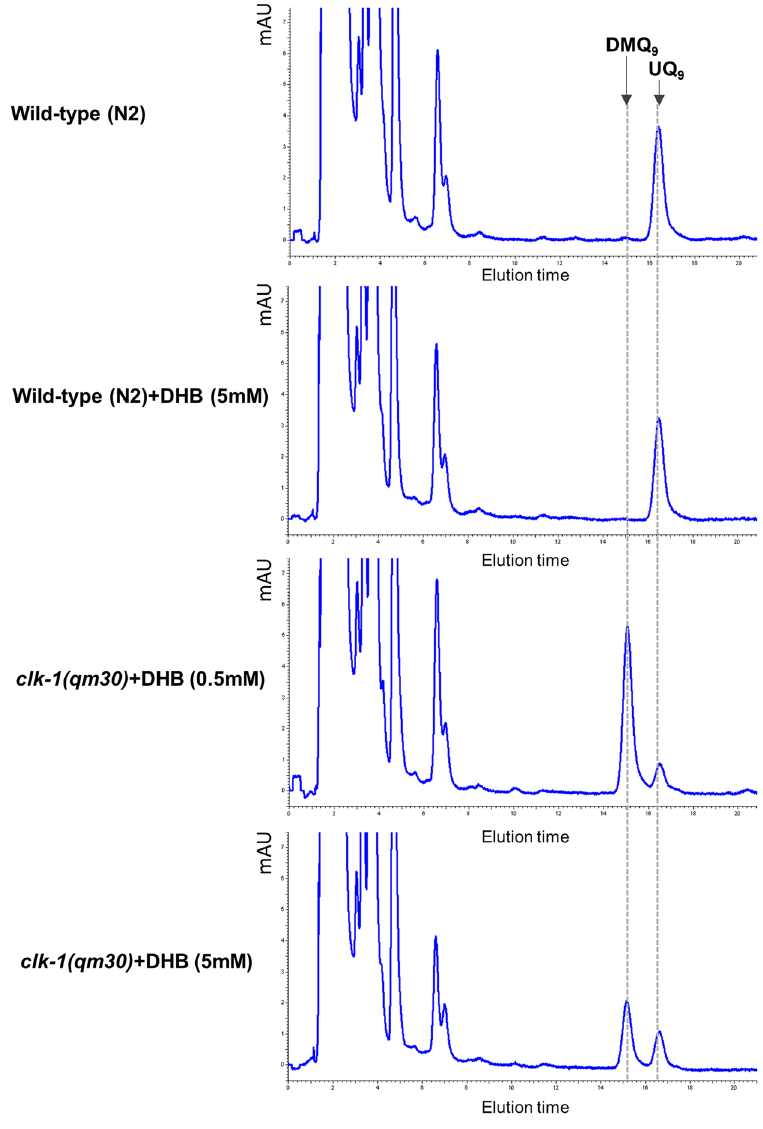
Figure 2. 2,4-DHB supplementation restores UQ biosynthesis in clk-1 mutants. HPLC-UV chromatograms of quinone extracts from worms with the indicated genotypes. Elution times for DMQ 9 and UQ 9 are indicated. At the first larval stage, the worms were transferred onto plates supplemented, or not, with DHB. They were fed the UQ-deficient bacterial strain GD1 and grown to the adult stage before being harvested for quinone extraction. Whole worm homogenates with 250 µ g of protein were used, expect for the clk-1 ( qm30 ) mutants exposed to DHB at 0.5 mM in the plate where a homogenate with 440 µ g of protein was used for HPLC analysis. Treatment with DHB restored UQ biosynthesis in clk-1 ( qm30 ) mutants in a dose-dependent manner, but showed no significant effect on the wild-type